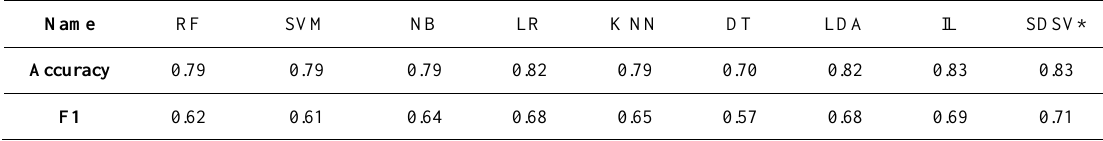
Table 3. Diabetes detection result: Pima Indians Diabetes